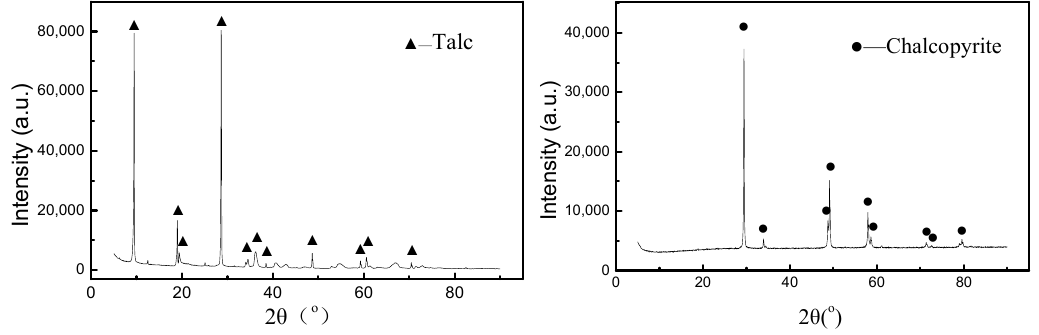
Figure 1. The X-ray diffraction patterns of talc and chalcopyrite samples.